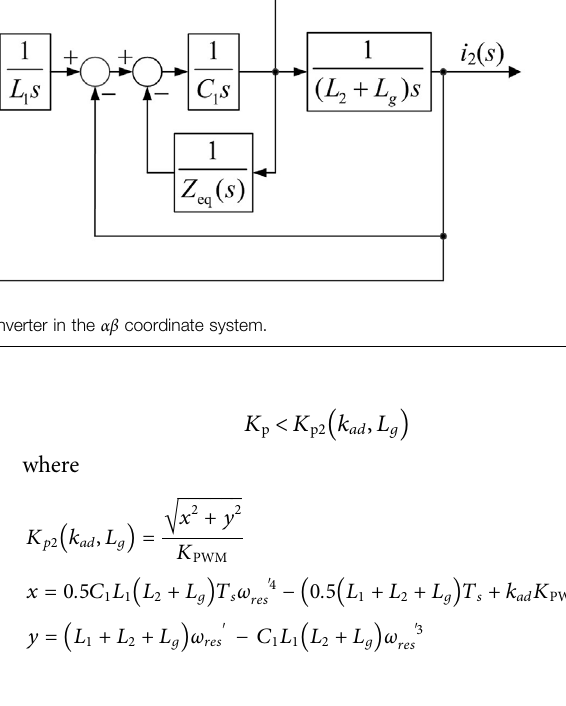
FIGURE 5 | Equivalent virtual impedance of active